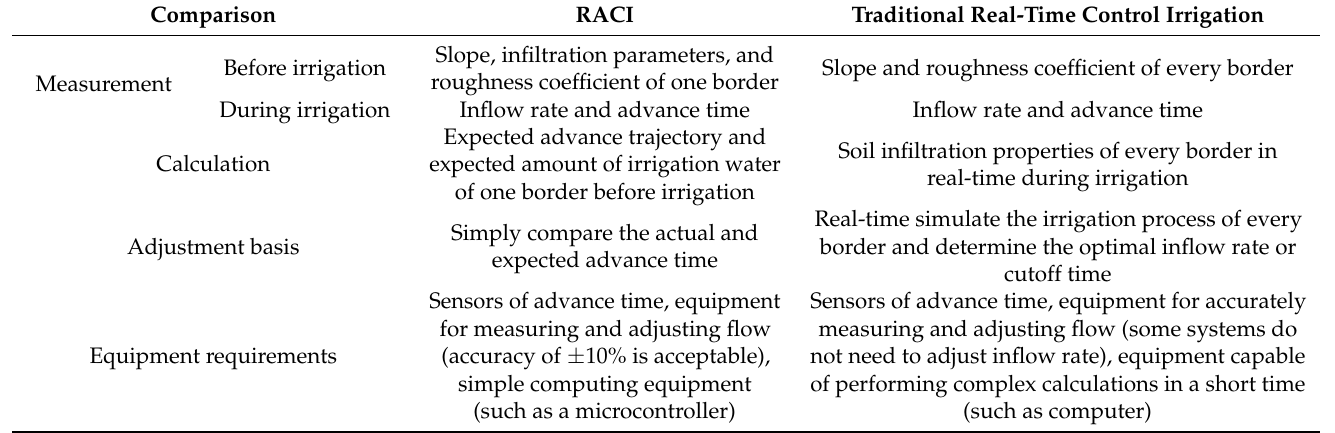
Table 5. Comparisons between RACI and traditional real-time control